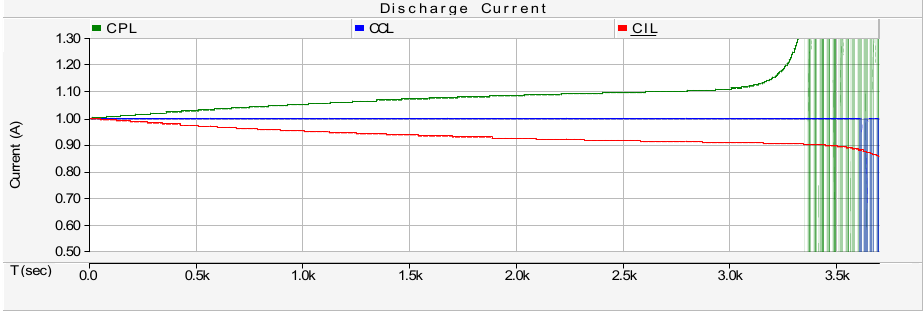
Figure 11. Battery discharge current response to a decrease in voltage (left to right).